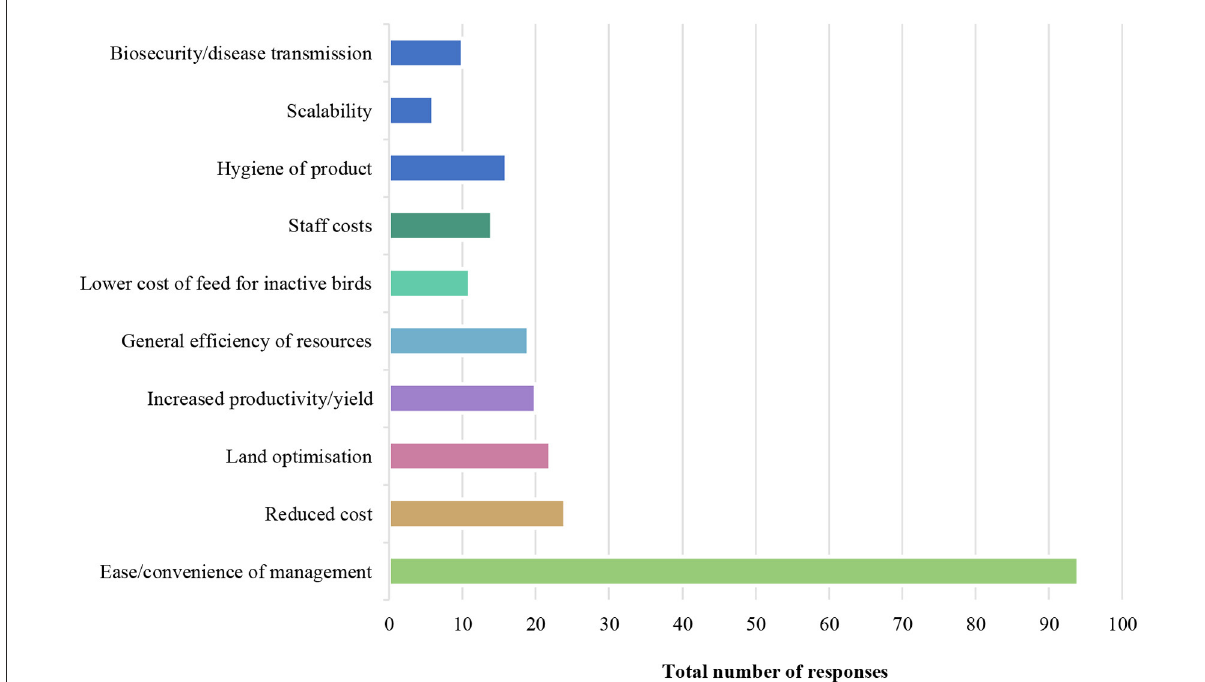
FIGURE1 Cage egg producers’ top 10 reasons for using cage over cage-free systems of production, displayed as the aggregate of data across all